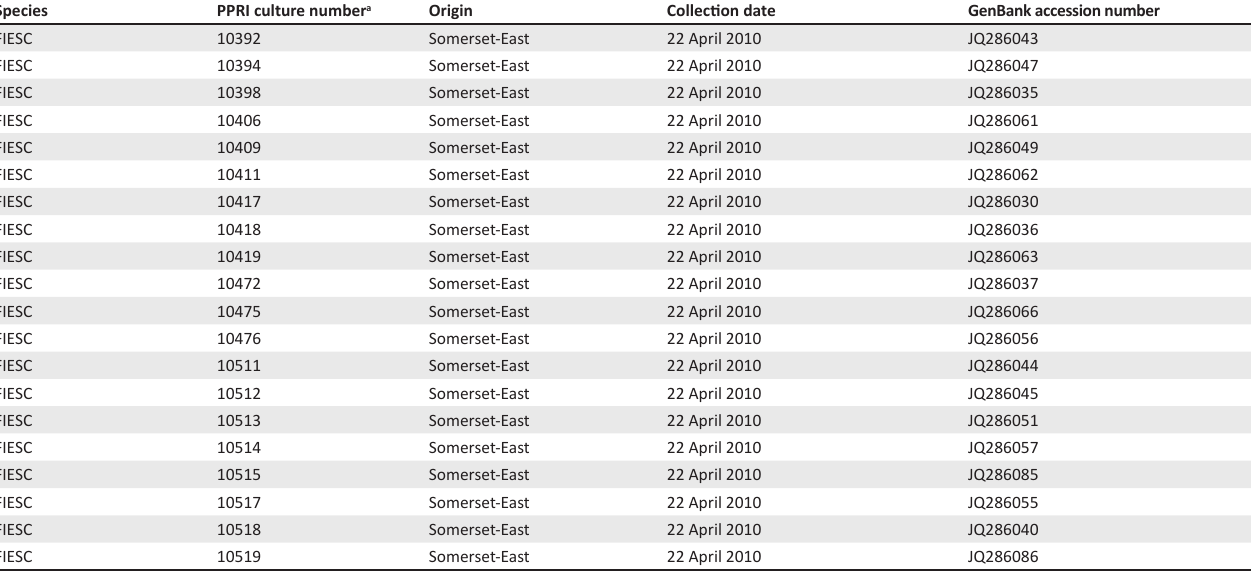
TABLE 1 (continues...): Fusarium isolates obtained from Pennisetum clandestinum collected during kikuyu poisoning outbreaks in the Eastern Cape Province of South